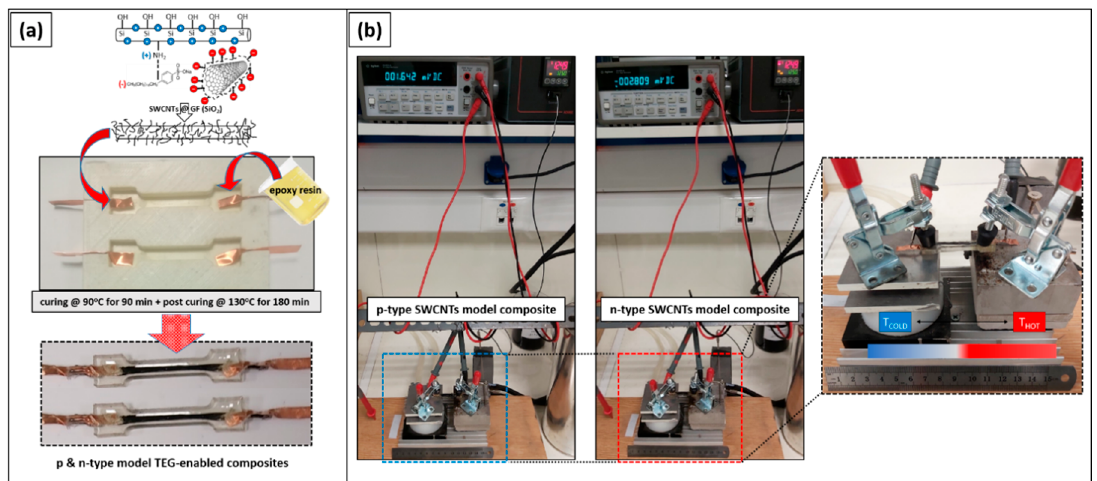
Figure 1. Manufacturing process of the thermoelectric generator (TEG)-enabled model composites ( a ) silicon mould utilized for the preparation of dog-bone shaped specimens with copper electrodes placed at both sides ready for the epoxy resin casting and ( b ) demonstration of the thermoelectric (TE)-enabled p and n-type model composites exposed to temperature gradient.